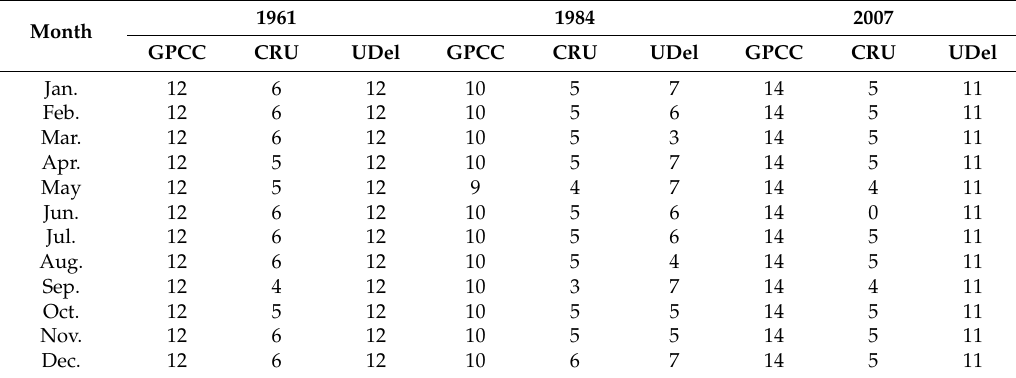
Table 3. Number of stations used by different datasets over